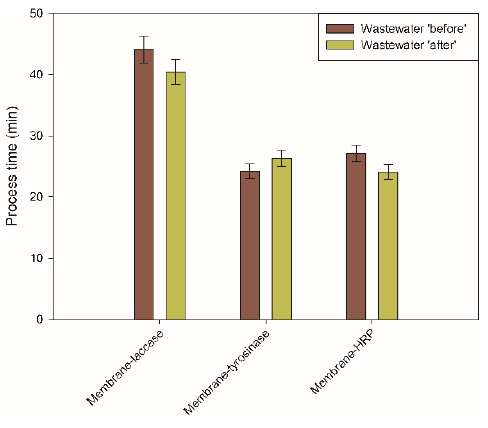
Figure 4. Process duration of the wastewater treatment experiments by various biocatalytic systems produced. All values are presented with a mean value of 3 experiments ± standard deviation.